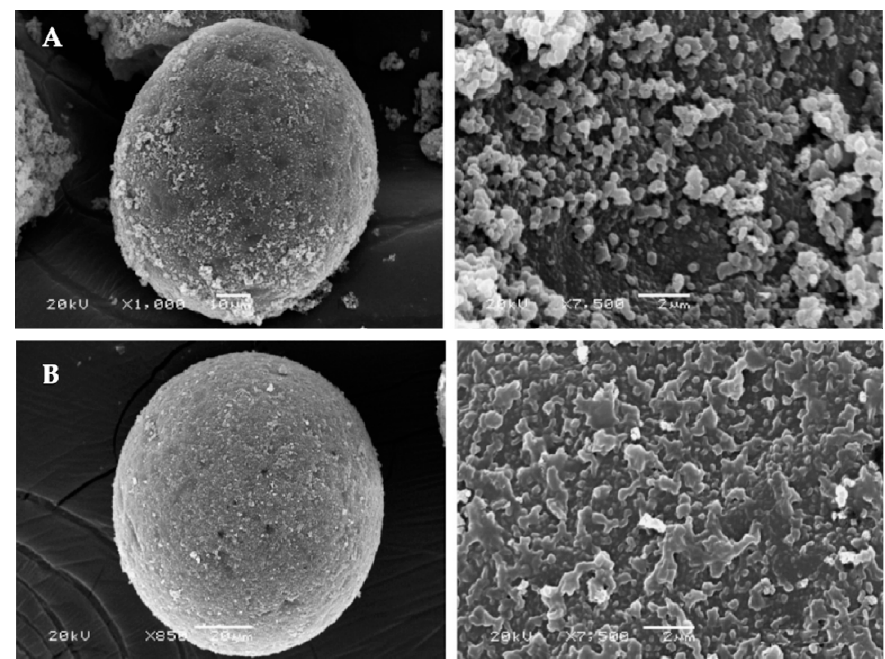
Figure 2. Scanning electron microscope images of ( A ) mercury (II)-imprinted polymeric beads and ( B ) nonimprinted polymeric beads. Republished with permission of Elsevier, from [23]; permission conveyed through Copyright Clearance Center, Inc.